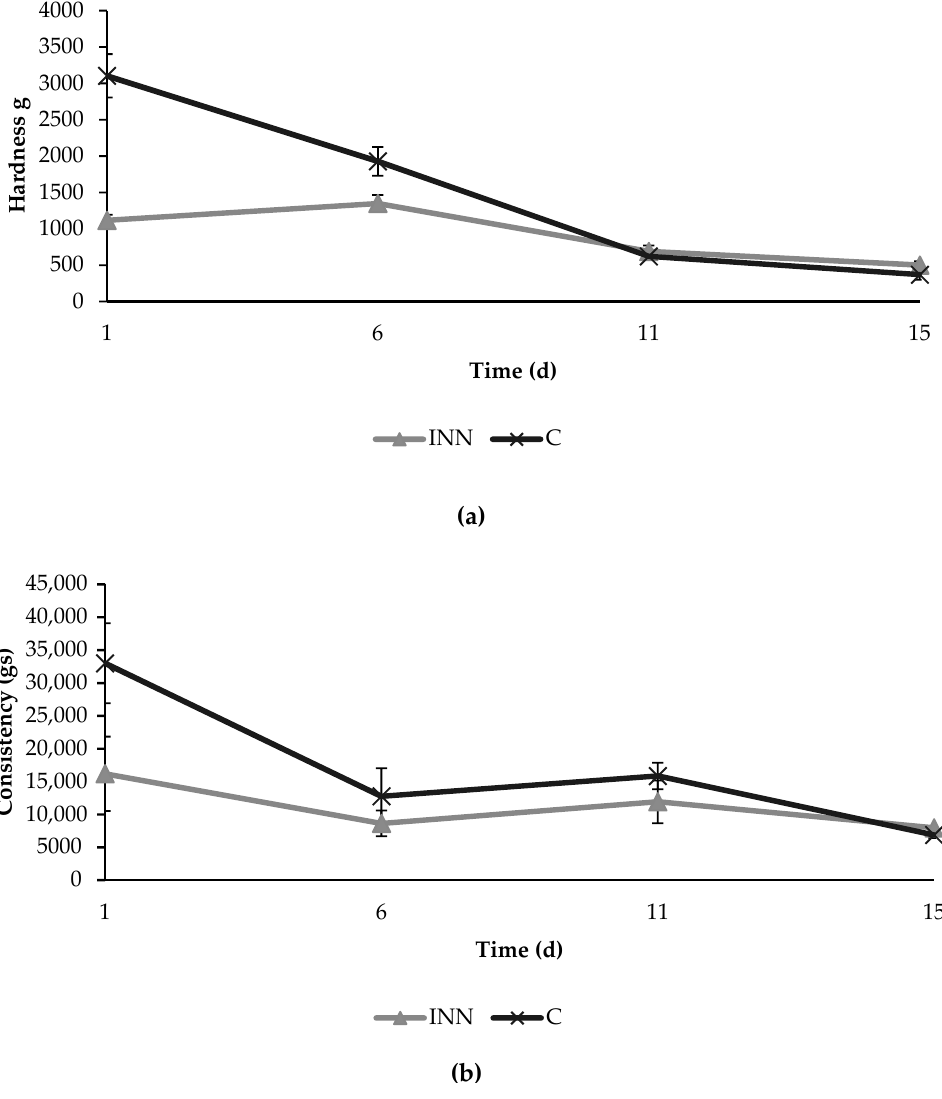
Figure 3. Texture parameters in terms of hardness ( a ) and consistency ( b ) detected in traditional (C) and innovative (INN) Squacquerone cheeses over the refrigerated storage.